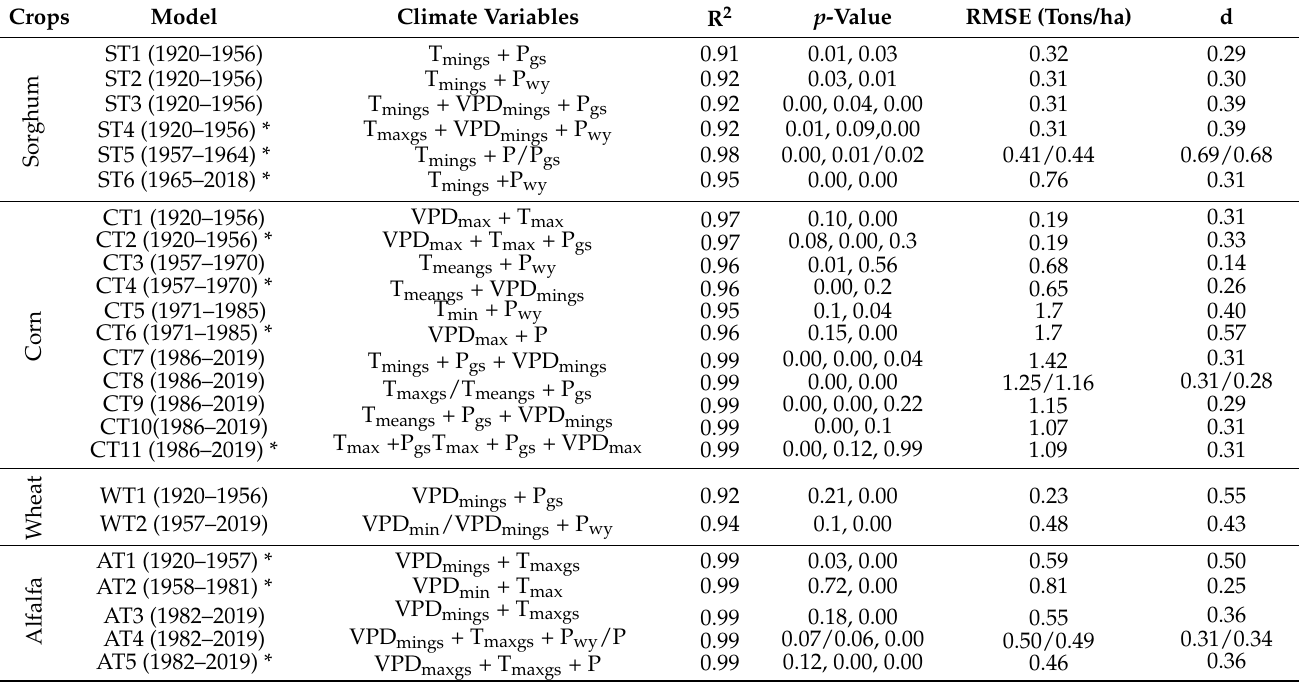
Table A2. The list of multiple linear regression models constructed with climate variables and crop yields of corn, sorghum, alfalfa, and wheat using segmented time scale from 1920 to 2019.